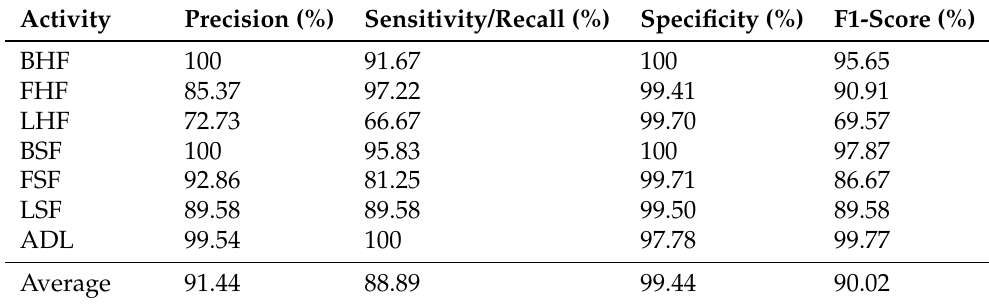
Table 3. Individual falls vs. ADL.